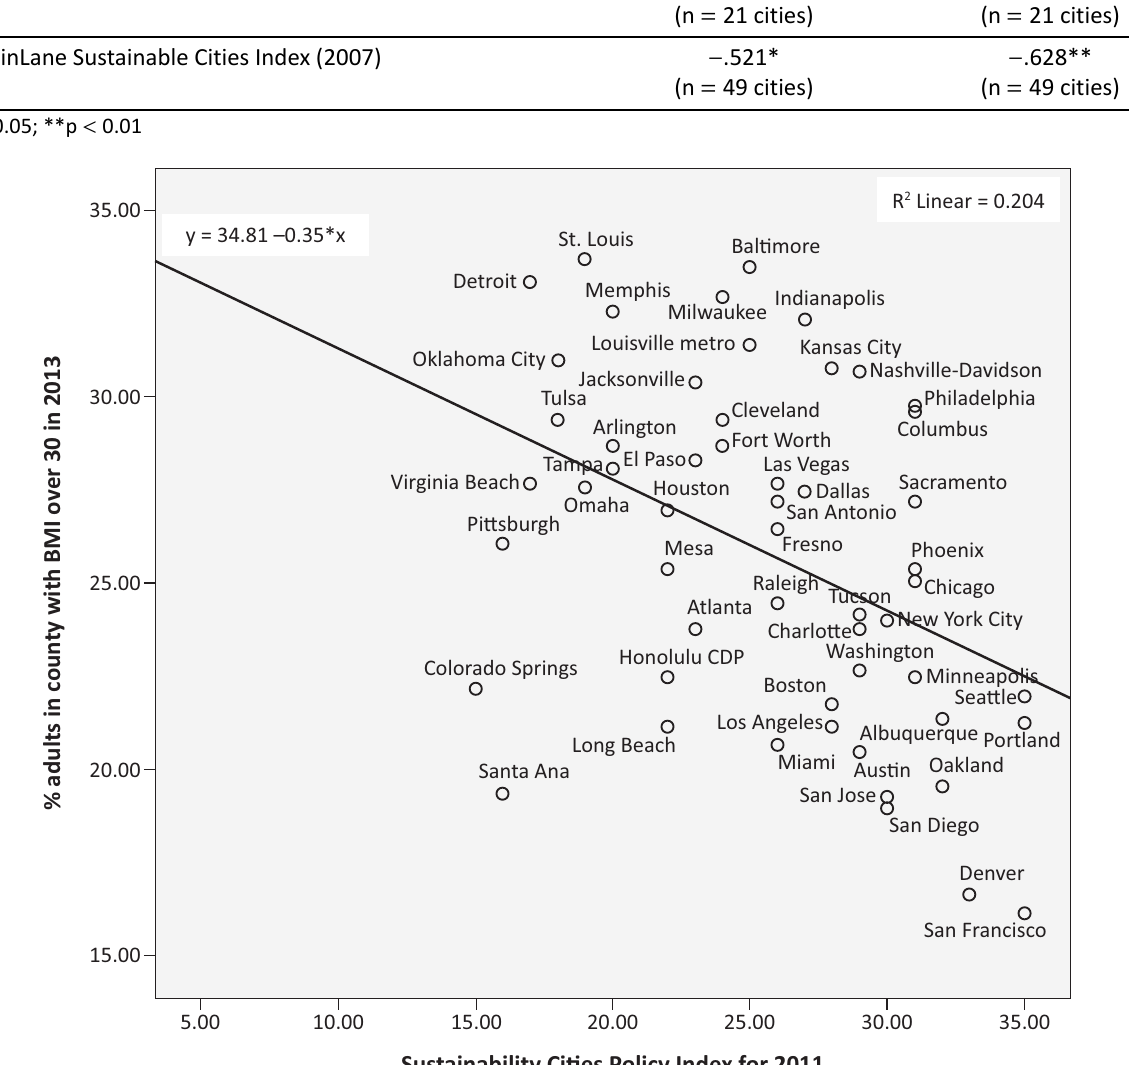
Figure 1. Scattergram showing the relationship between the Sustainable Cities Policies Index and the percent of adults with BMI over 30 for the 55 largest U.S.